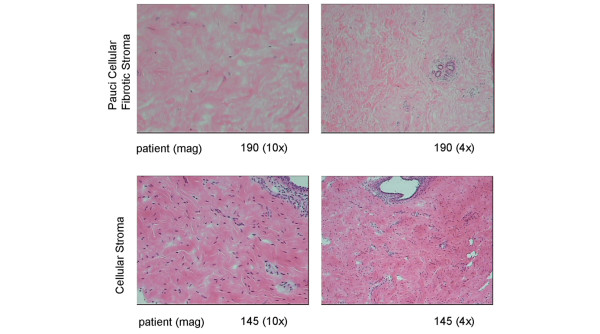
Images of pauci cellular fibrotic and cellular stroma sections from selected patients. Images were taken at 4× and 10× magnification.